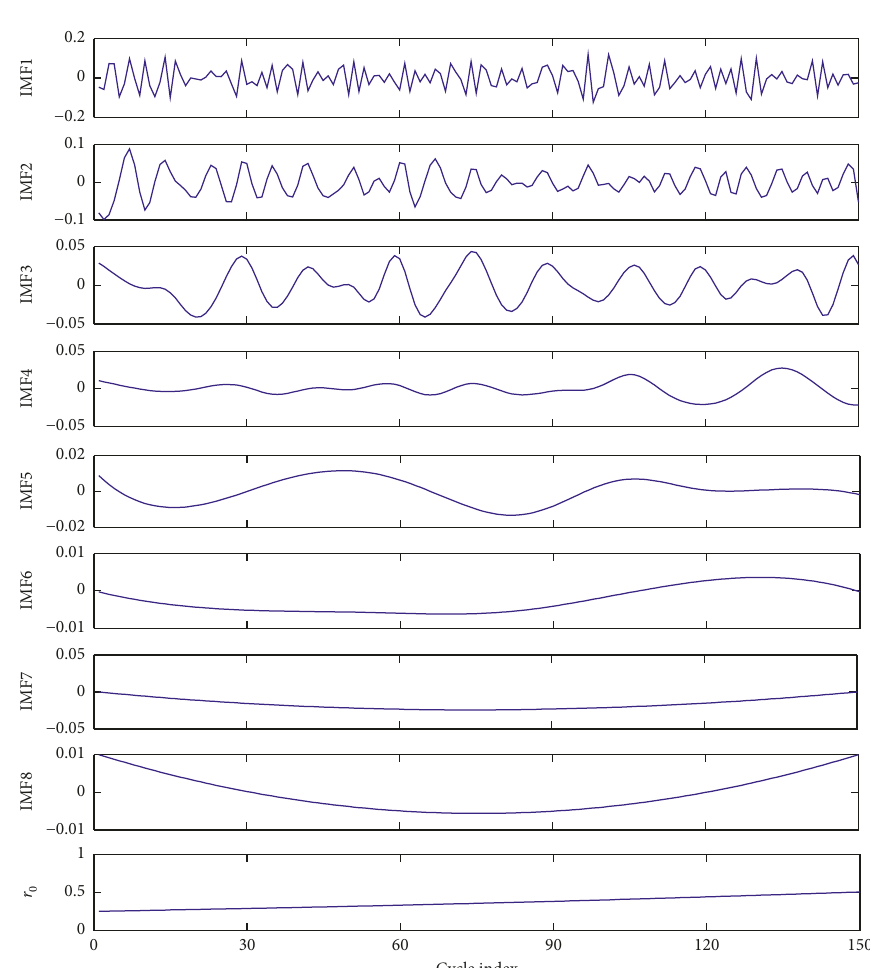
Figure 6: CEEMDAN decomposed results of the generated IDI